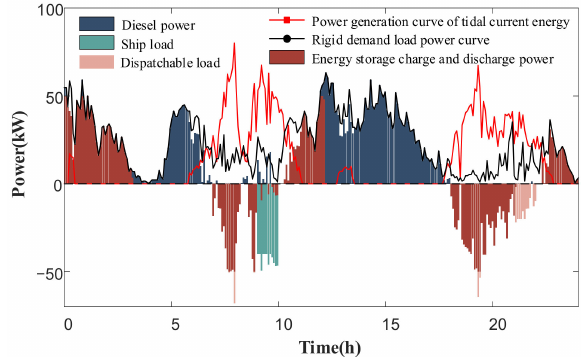
Figure 12. The results of the real-time